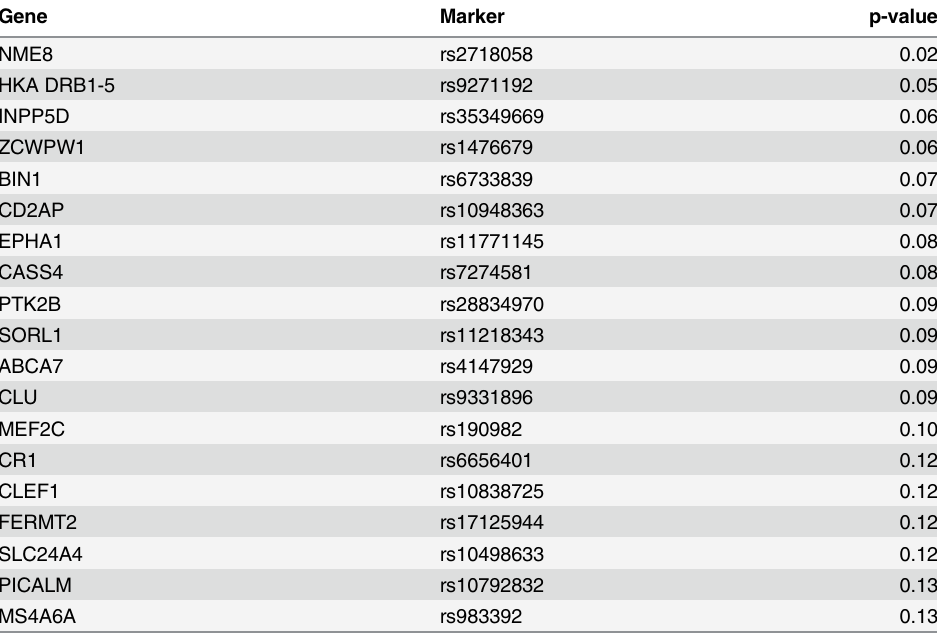
Table 4. Associations between published AD SNPs and diagnostic